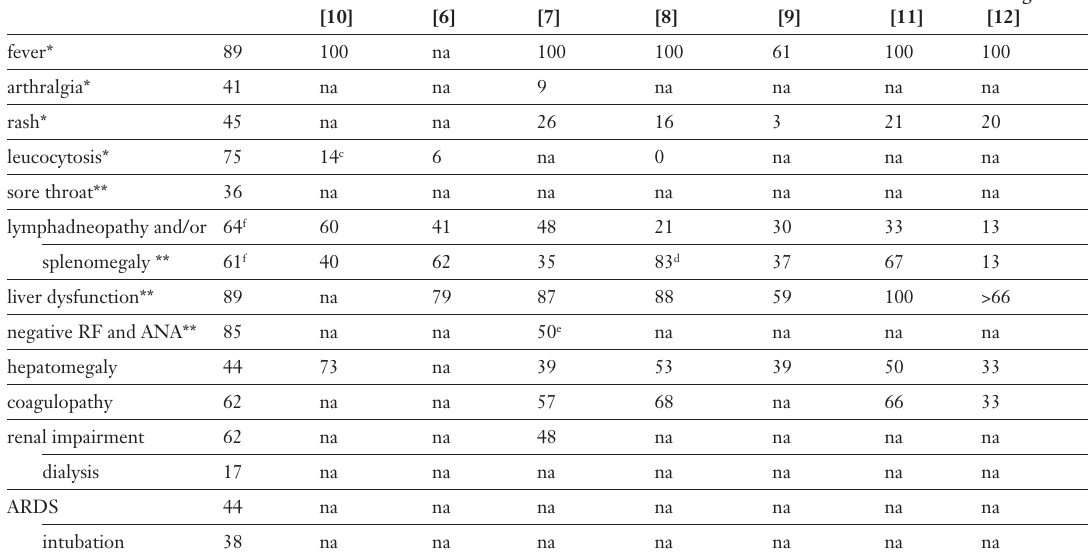
Various clinical findings focused on Yamaguchi’s criteria for adult-onset Still’s diseasea